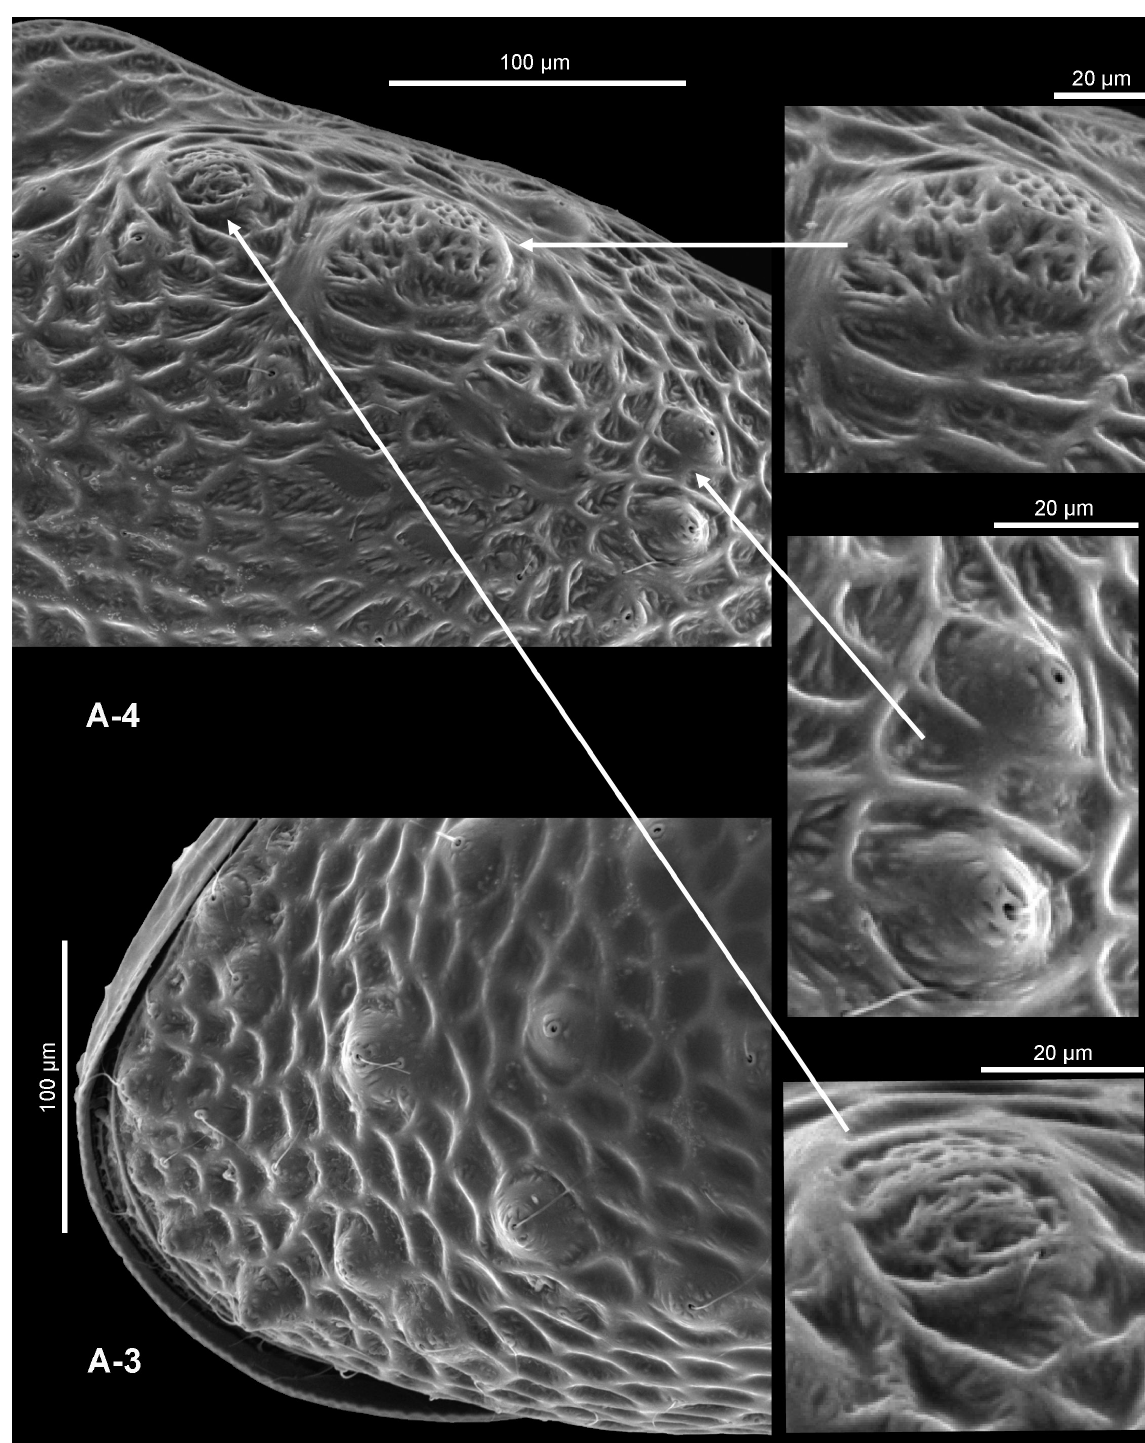
Fig. 15. Detailed views of the domes and cones of A-3 and A-4 specimens of Bennelongia kimberleyensis Martens et al ., 2012 from Taylor’s Lagoon. Note the micro-reticulated nature of the domes seen in the top left image in comparison with the rest of the valve the domes are enlarged in the top and bottom images on the right. The bottom left image and middle image on the right clearly show the cones with a lip near the apex and the protruding seta adorning each